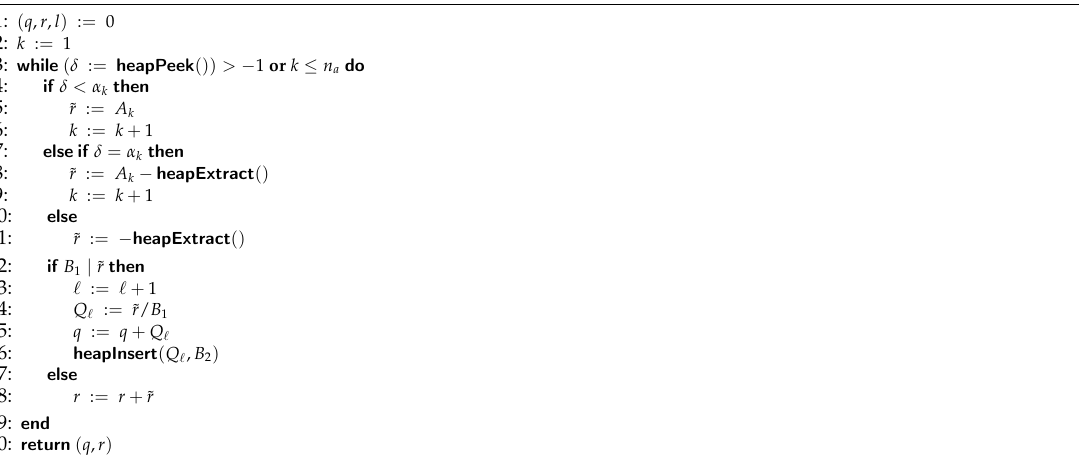
Algorithm 4 HEAP D IVIDE P OLYNOMIALS ( a , b